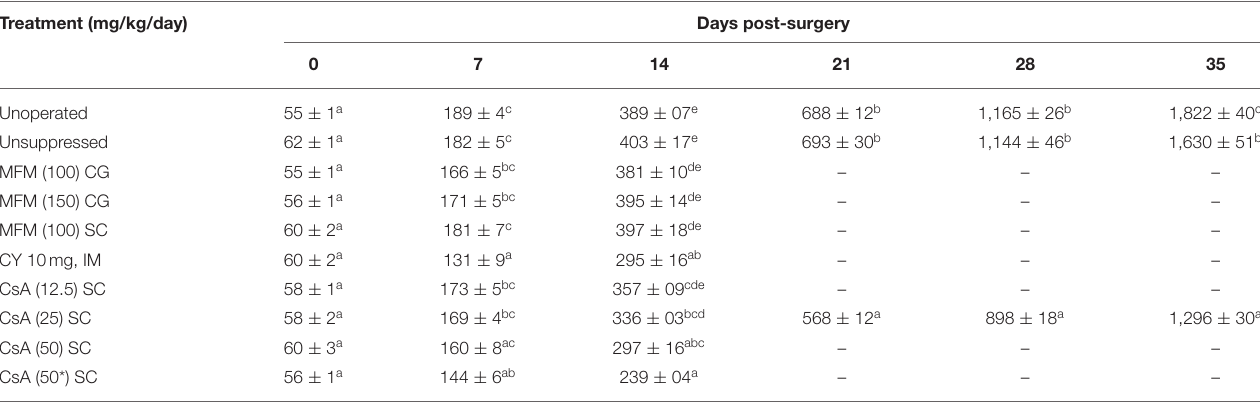
TABLE 3 | Poult body weight (g) from 0 to 35 days post-surgery, from Study 2 and 3. Treatment (mg/kg/day)